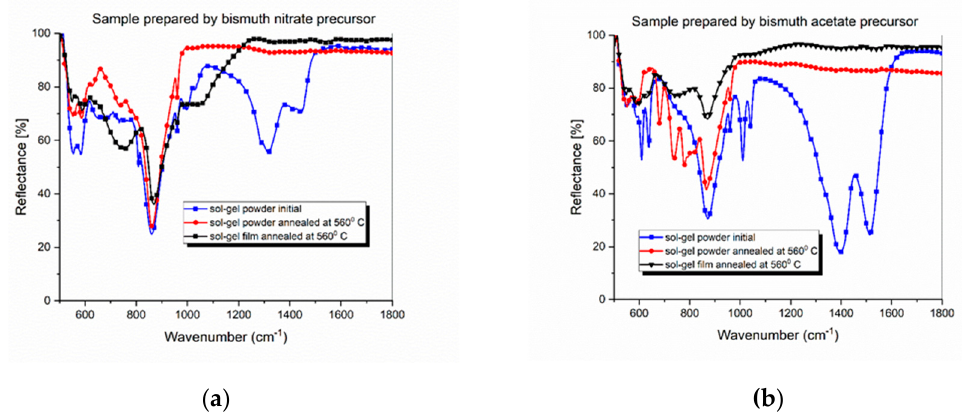
Figure 7. ( a ) FTIR spectra of the sample prepared by the bismuth nitrate precursor; ( b ) FTIR spectra of the sample prepared by the bismuth acetate precursor.